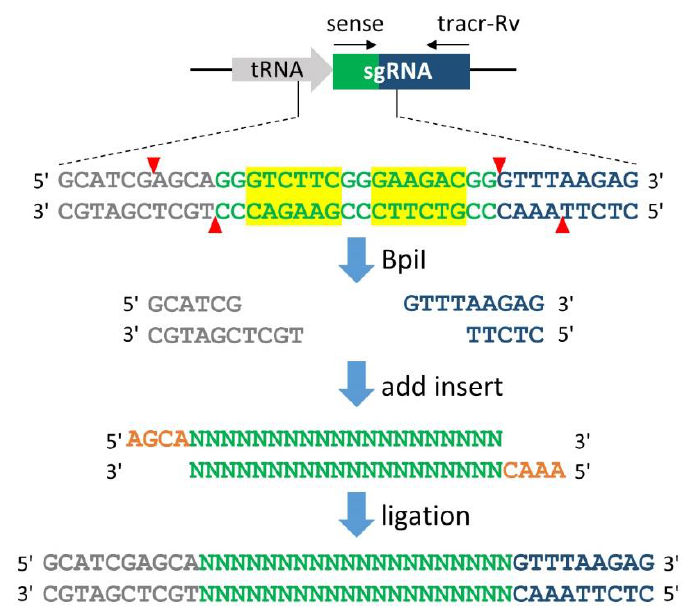
Figure 3. Generation of the single-guide RNA (sgRNA) expression vector. A pair of annealed oligonucleotides is easily cloned into the tRNA-sgRNA junction via BpiI restriction sites. The overhang sequences 5 (cid:48) -AGCA-3 (cid:48) (orange) for the sense oligonucleotide and 5 (cid:48) -AAAC-3 (cid:48) (orange) for the antisense oligonucleotide are compatible with the ends of BpiI-digested overhangs. The sense oligonucleotide is the 20-nucleotides target sequence preceding 5 (cid:48) -NGG-3 (cid:48) (PAM sequence) in genomic DNA; thus, the PAM sequence should not be included in the oligonucleotide. After mixing the two oligonucleotides in equal molar amounts, the mixture is heated at 95 ◦ C for 5 min and slowly cooled to 25 ◦ C (1 ◦ C/min) using a thermal cycler. The annealed oligonucleotide pairs are then ligated into the BpiI-digested vector via the Golden Gate digestion/ligation reaction performed in a thermal cycler using five cycles of 37 ◦ C for 5 min and 16 ◦ C for 15 min. After the cycle is finished, an additional BpiI digestion is performed at 37 ◦ C for 60 min to prevent the contamination of the non-integrated vector before bacterial transformation. Black arrows indicate primers used for colony PCR, sense; target sense oligonucleotide, tracr-Rv; 5 (cid:48) -AAGCTTAAAAAAAGCACCGACTCGGTGCC-3 (cid:48) . Yellow boxes indicate BpiI recognition sites and red arrowheads denote their cleavage sites. Grey, green and blue denote tRNA, the target sequence and tracrRNA,